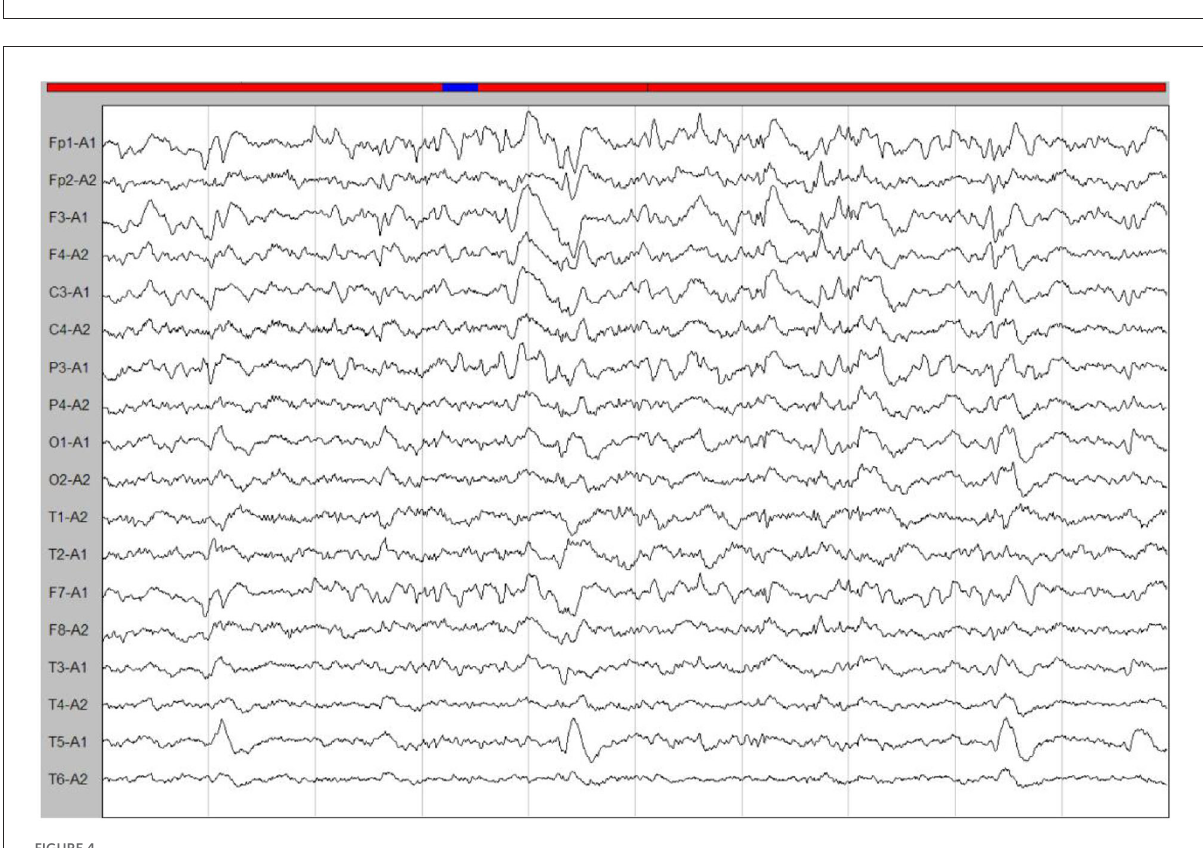
FIGURE3 Pedigree of the family with Krabbe disease (A) and genetic evaluation of GALC (B) . The pedigree chart shows that the patient’s father (I-1) and mother (I-2) were cousins. The proband (II-1) is indicated by a black arrow. The genetic evaluation showed that the c.1901T > C (p.Leu634Ser) mutation of the proband was inherited from her parents.